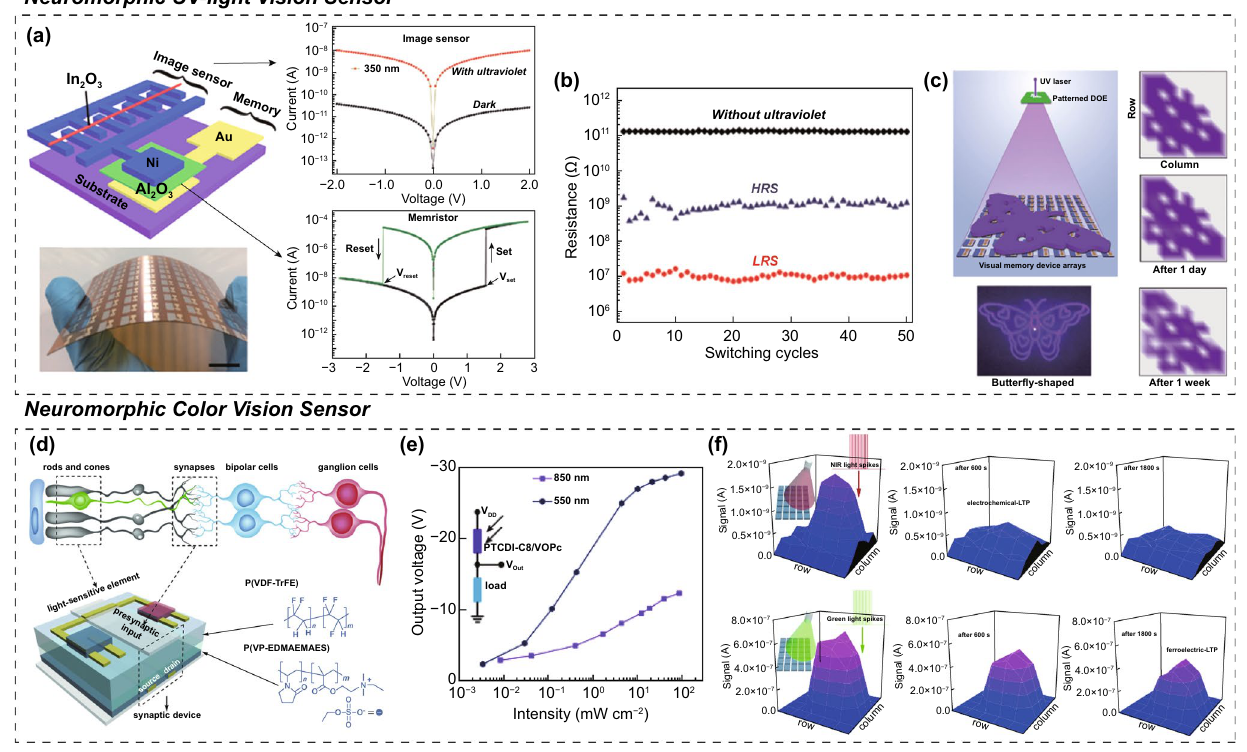
Fig. 3 OSC for near‑sensor computing system; circuit configuration and neuromorphic vision perception. Neuromorphic ultraviolet (UV)‑light vison sensor; a circuit schematic consisting of photo‑sensor and memristor‑type electrical synapse (ES), b conductance switching behavior in electrical memristor and its operation mechanism, and c neuromorphic perception of UV‑light butterfly pattern image. Neuromorphic color‑ vison sensor; d circuit schematic consisting of photo‑sensor, load, and transistor‑type ES, e photo‑to‑bias conversion performance of photovol‑ taic divider, and f neuromorphic perception of color and near‑infrared (IR) images. a – c Reproduced with permission from Ref. [11]. Copyright @ 2018, Wiley‑VCH. d – f Reproduced with permission from Ref. [14]. Copyright @ 2018,